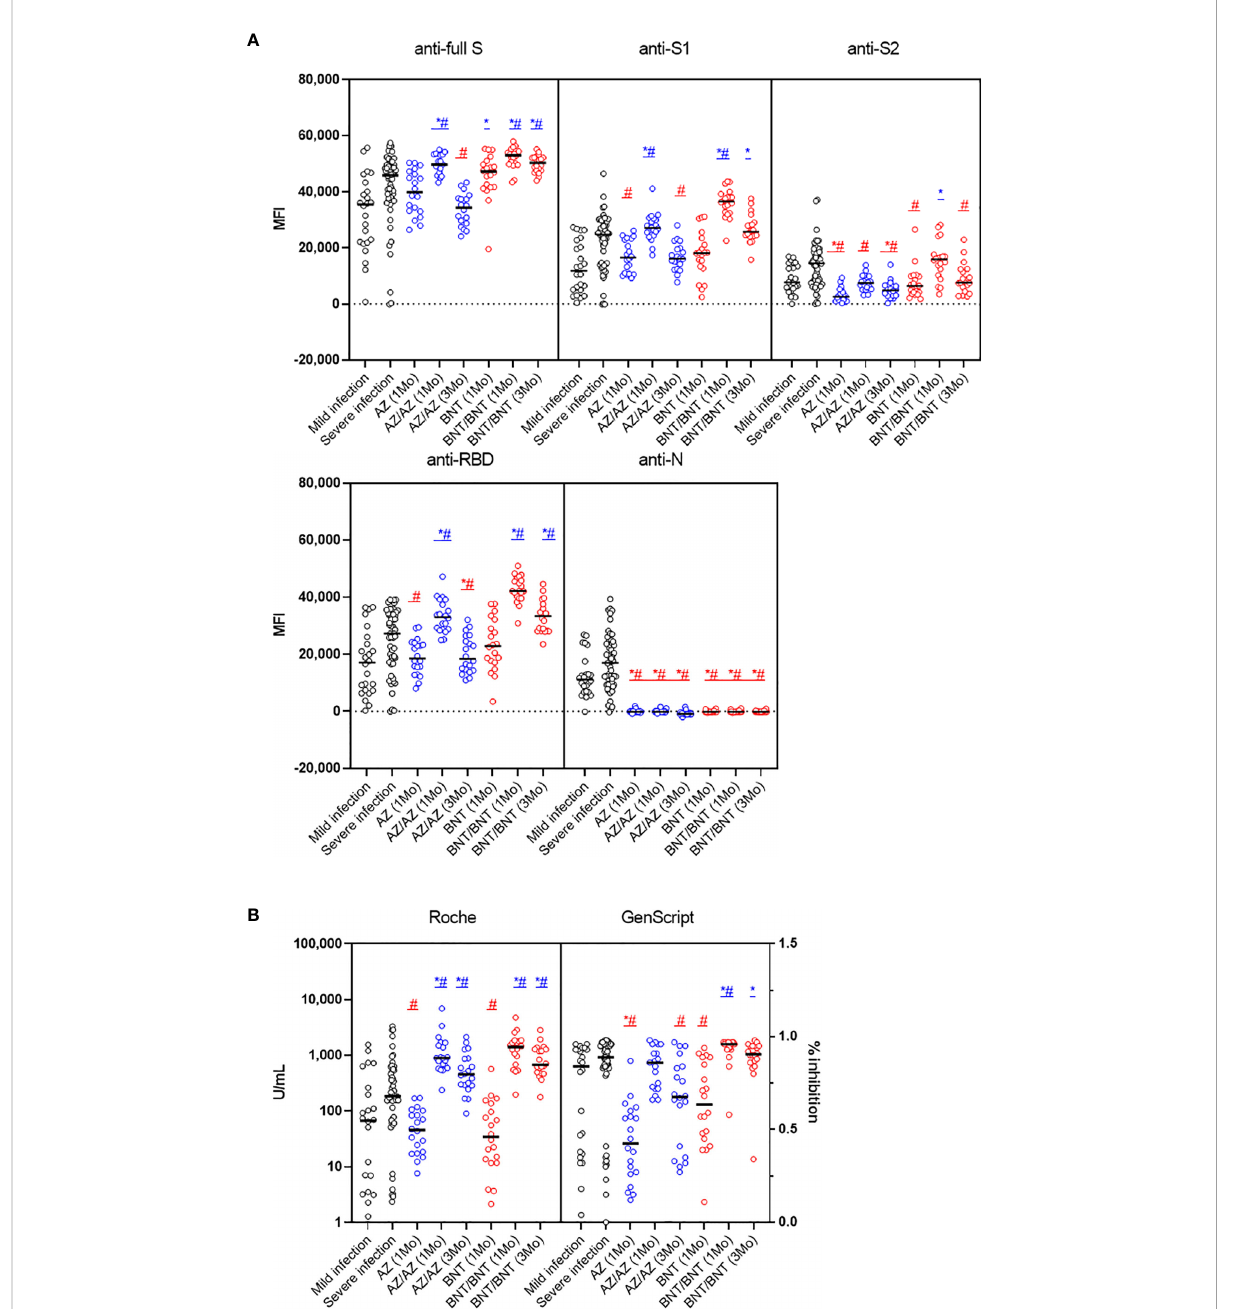
FIGURE 3 Comparison of early SARS-CoV-2 antibody levels by multiplex bead assay (A) and Roche and GenScript assays (B) in COVID-19 patients (>14 days from symptom onset) versus naïve vaccinated HCWs until 3 months after AZ or BNT boost vaccination. Blue markers (*, #) indicate higher and red markers indicate lower antibody levels in vaccination versus post-infection. *mild infection vs. vaccination (P < 0.05), #severe infection vs. vaccination (P <